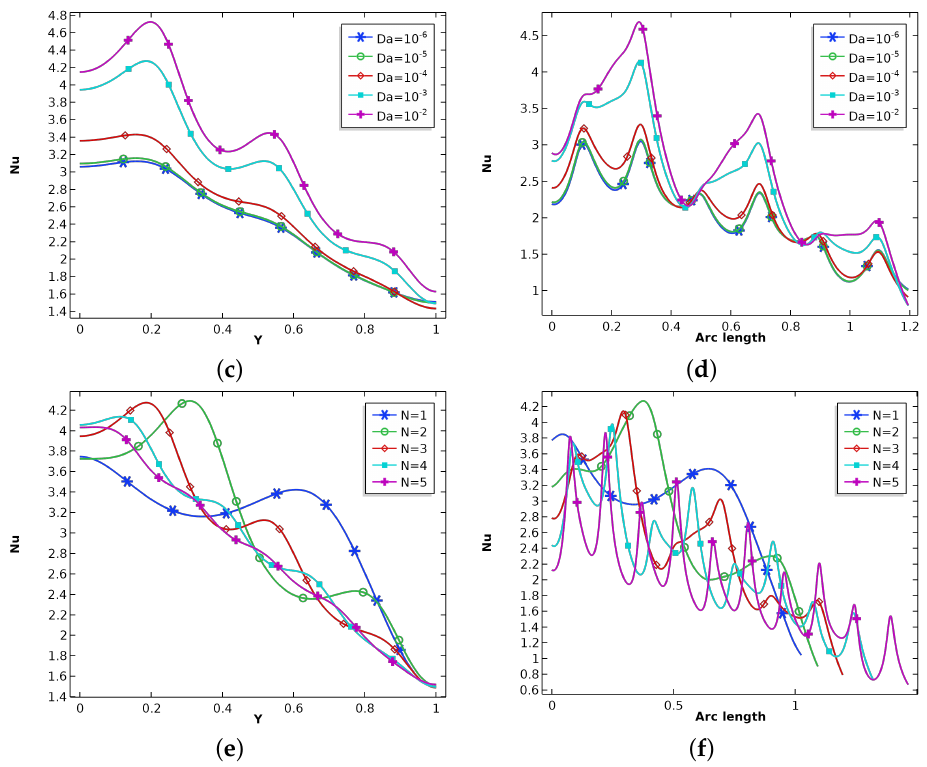
Figure 9. Local Nusselt number Nu for different values of Rayleigh, Darcy and Undulation numbers.